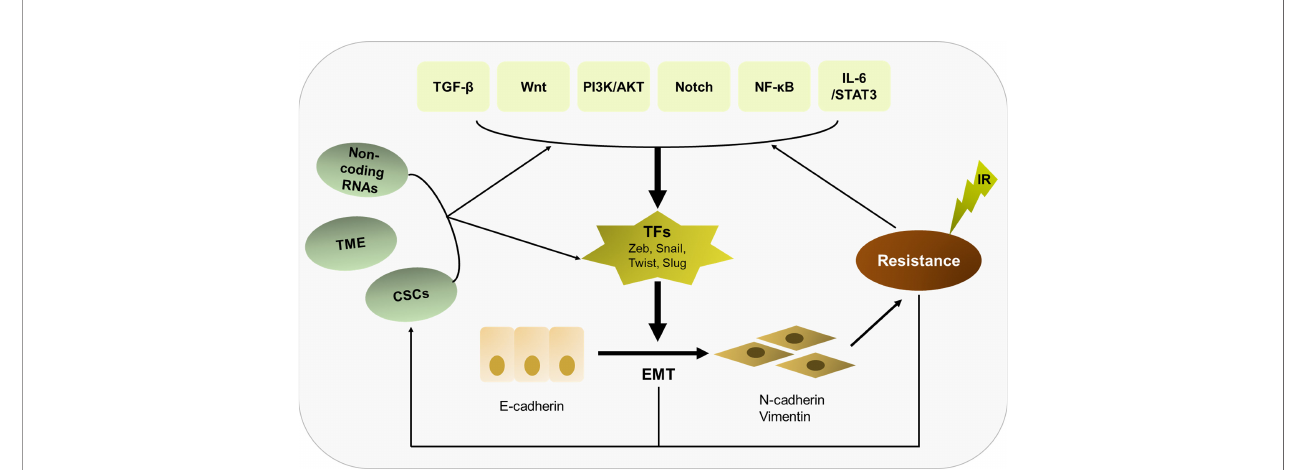
FIGURE 3 | Overview of the relationship of EMT with radioresistance and their crosslinked mechanisms. EMT plays a central role in eliciting radioresistance. Multiple molecular mechanisms are involved in EMT-induced radioresistance, including TGF- b , Wnt, PI3K/AKT, Notch, NF- k B, IL-6/STAT3, non-coding RNAs, CSCs and tumor microenvironment. Besides, there is a vicious circle between EMT and irradiation. Irradiation can further enhance the EMT program, thus strengthening